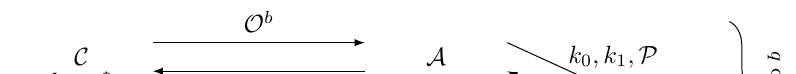
, . . . , v b ) of the probed wire values v b t 1